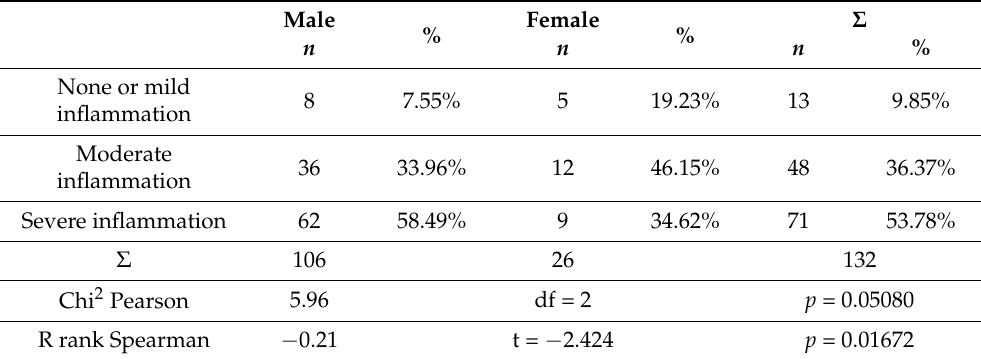
Table 4. Division of periodontitis according to Page and Eke classification in the study population after myocardial